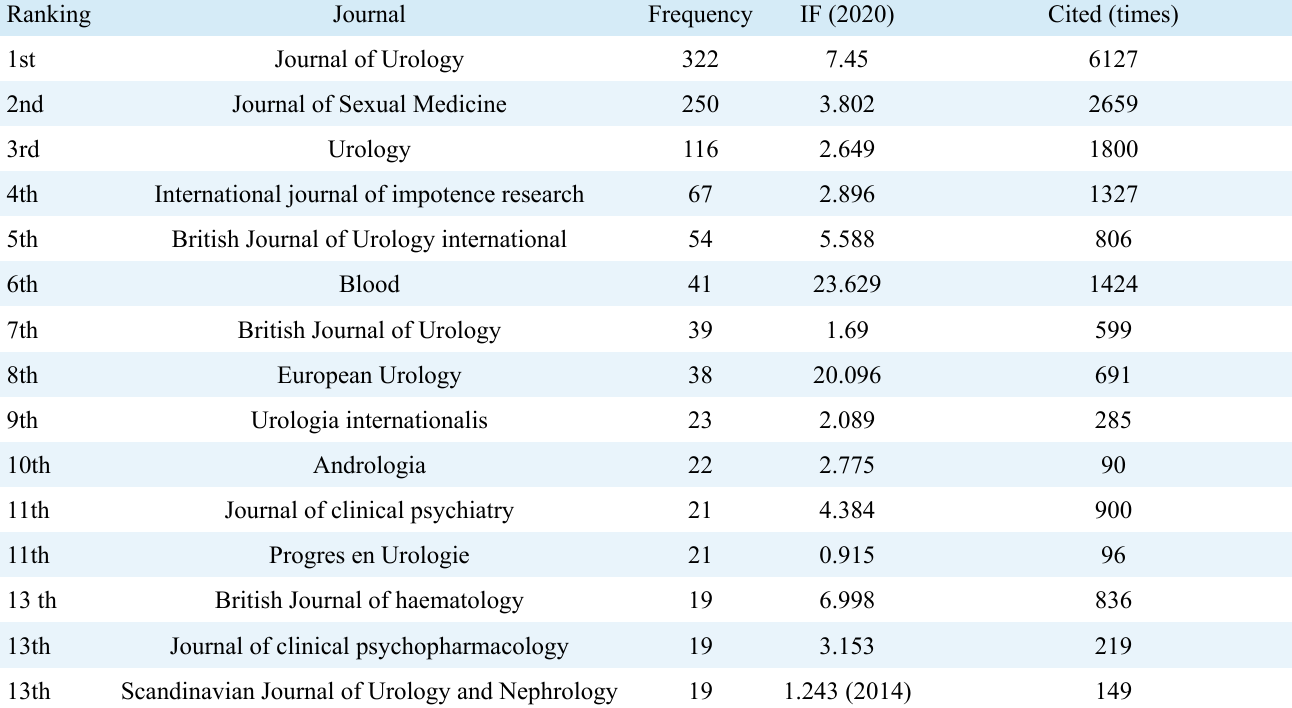
FIGURE 1. The number of publications changes with the year. TABLE 2. The top 15 productive and cited journals on the research of